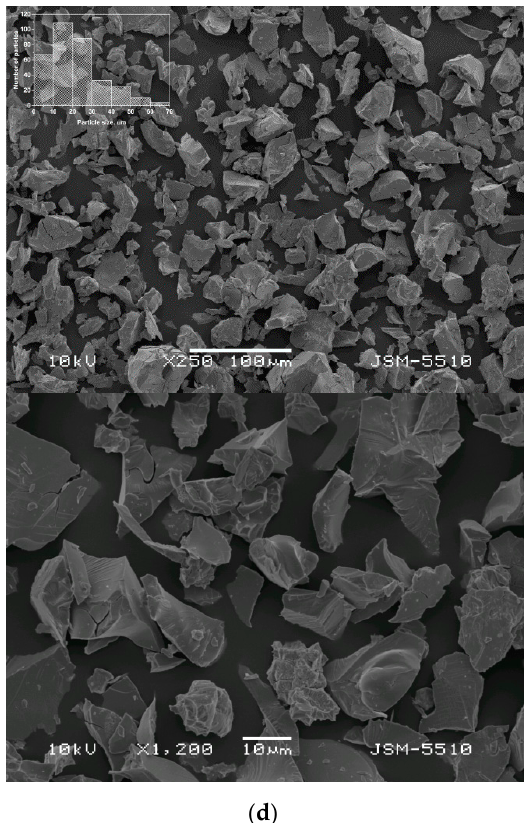
Figure 2. Scanning electron microscopy micrographs of LaNi 5 based alloys and particle size distribution histograms, ( a ) LaNi 5 ; ( b ) LaNi 4.3 Co 0.4 Al 0.3 ; ( c ) LaNi 4.8 Sn 0.2 ; ( d ) LaNi 4.3 Sn 0.3.